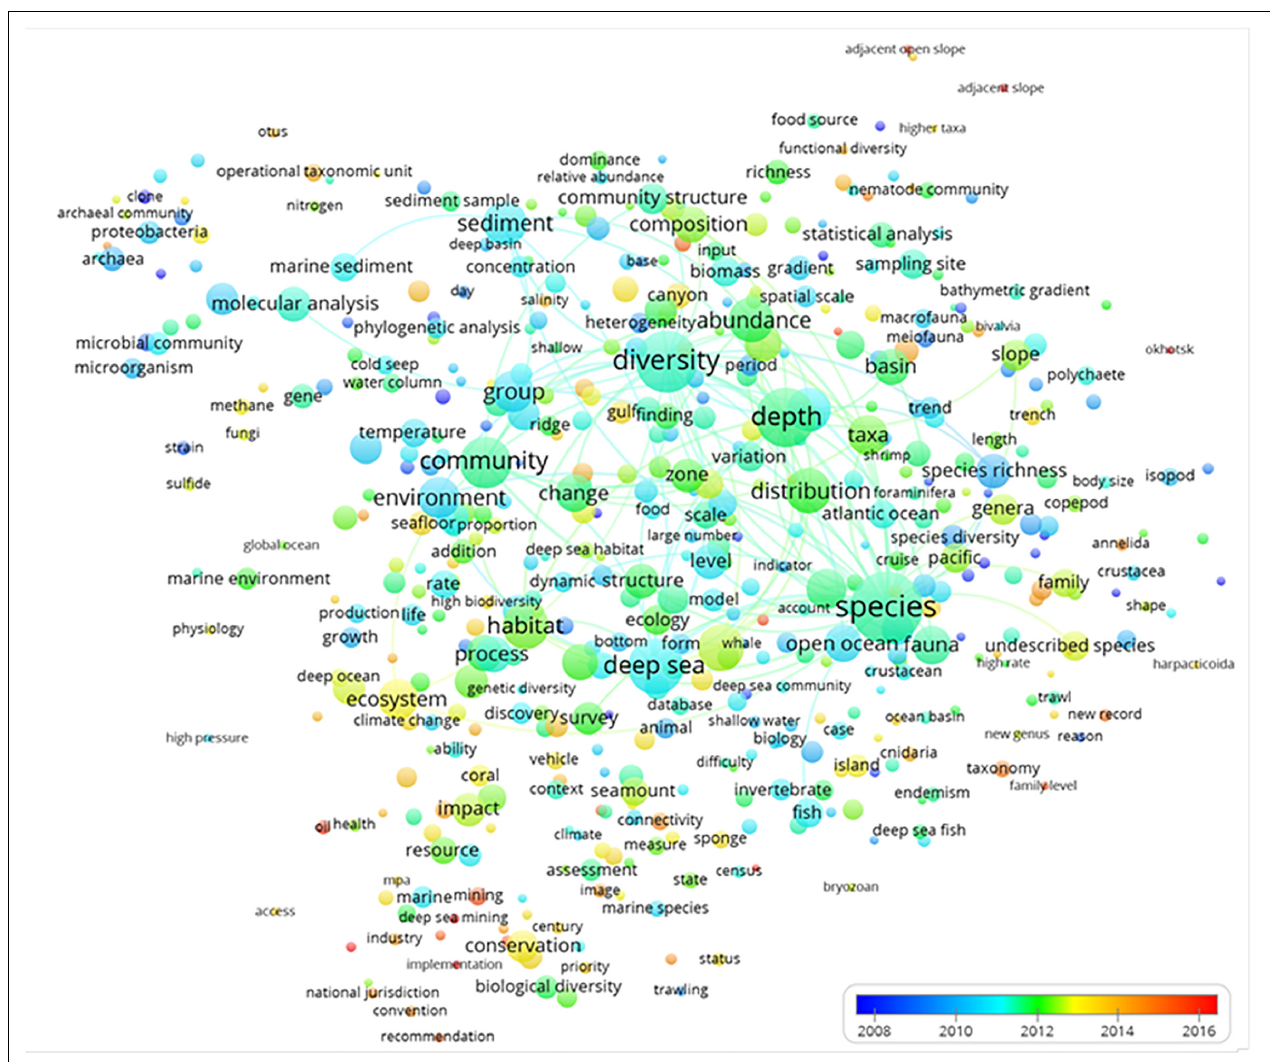
FIGURE 5 | The term average normalized map analysis based on deep-sea biodiversity publications per year. The colors are used to identify clusters of year of publication, with a scale that represents the earlier (blue) or more recent (red) years when the term appeared. Lines indicate at least 100 co-occurrence links between